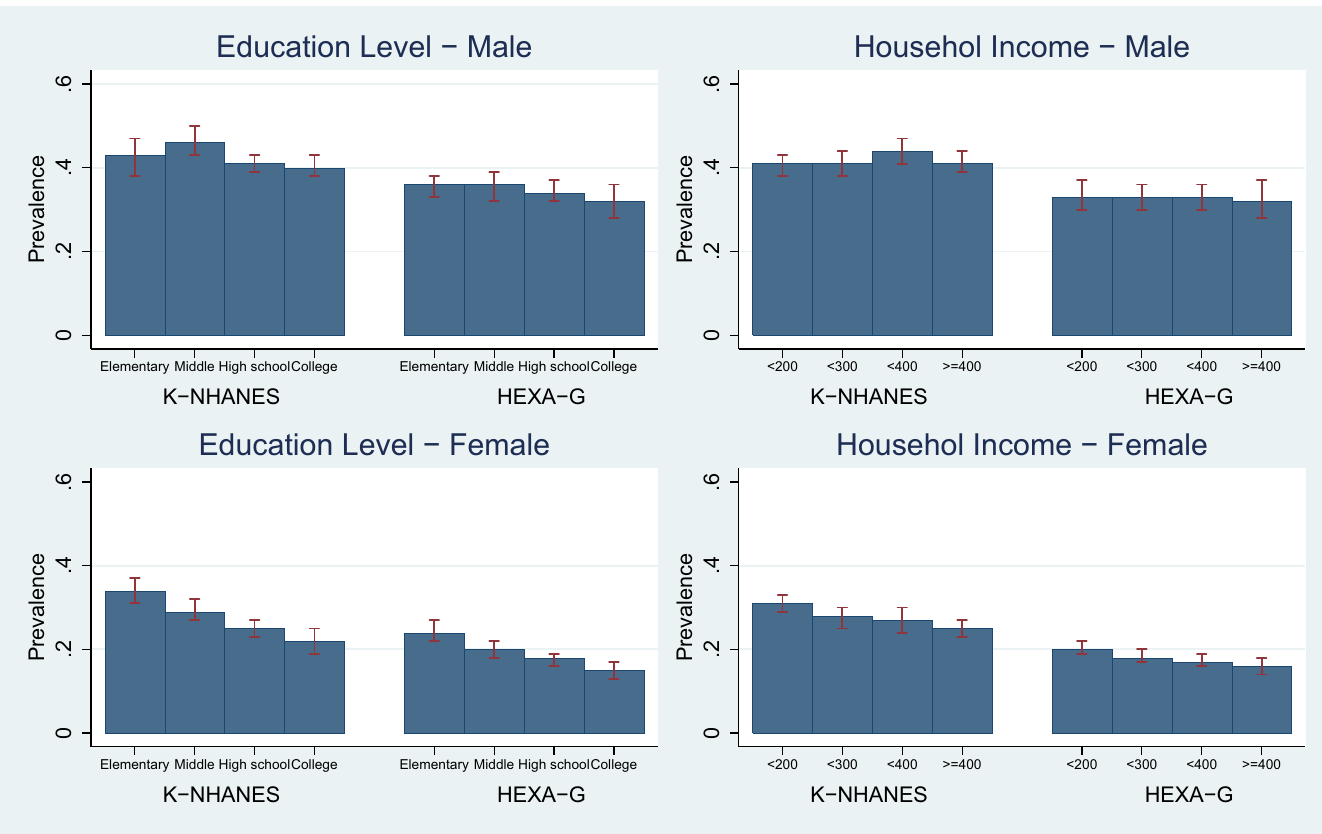
Fig 5. Age-standardized prevalence: Elevated blood glucose. K-NHANES: Korea National Health and Nutrition Examination Survey; HEXA-G: Health Examinees- Gem. Elevated fasting plasma glucose (FPG) (cid:21) 100 mg/dL (5.6 mmol/L) or specific treatment for this glucose abnormality.